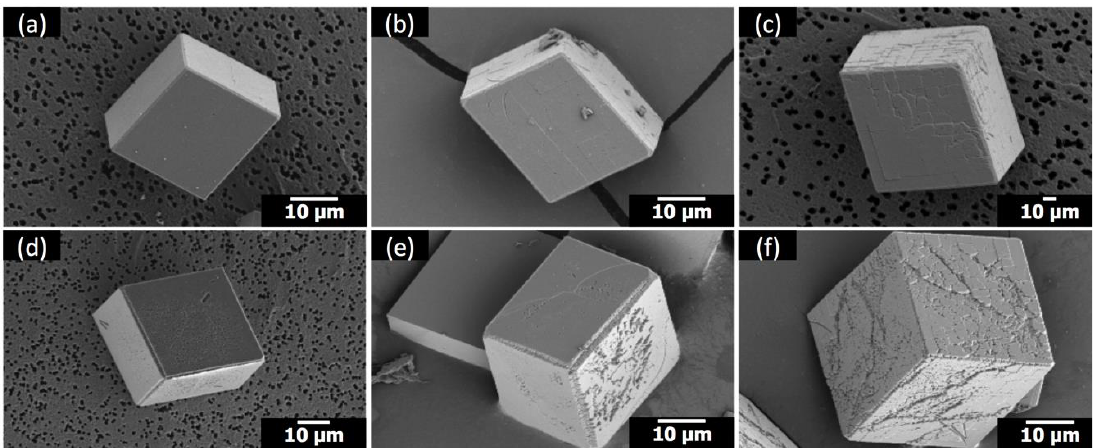
Figure 6. SEM images of the calcite crystals formed with: ( a ) 1 µ M poly(ethylene imine) (PEI) (no Sr); ( b ) 1 µ M PEI at Sr / Ca = 1:100; ( c ) 1 µ M PEI at Sr / Ca = 1:25; ( d ) 5 µ M PEI (no Sr); ( e ) 5 µ M PEI at Sr / Ca = 1:100; ( f ) 5 µ M PEI at Sr / Ca = 1:25.